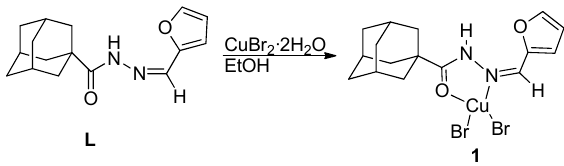
Table 1. Crystal data and structure refinement parameters for 1